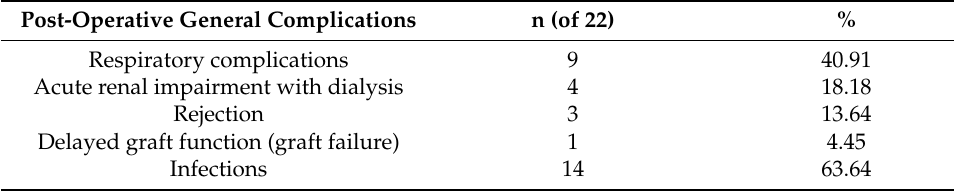
Table 3. Peri-operative non-neurological complications.